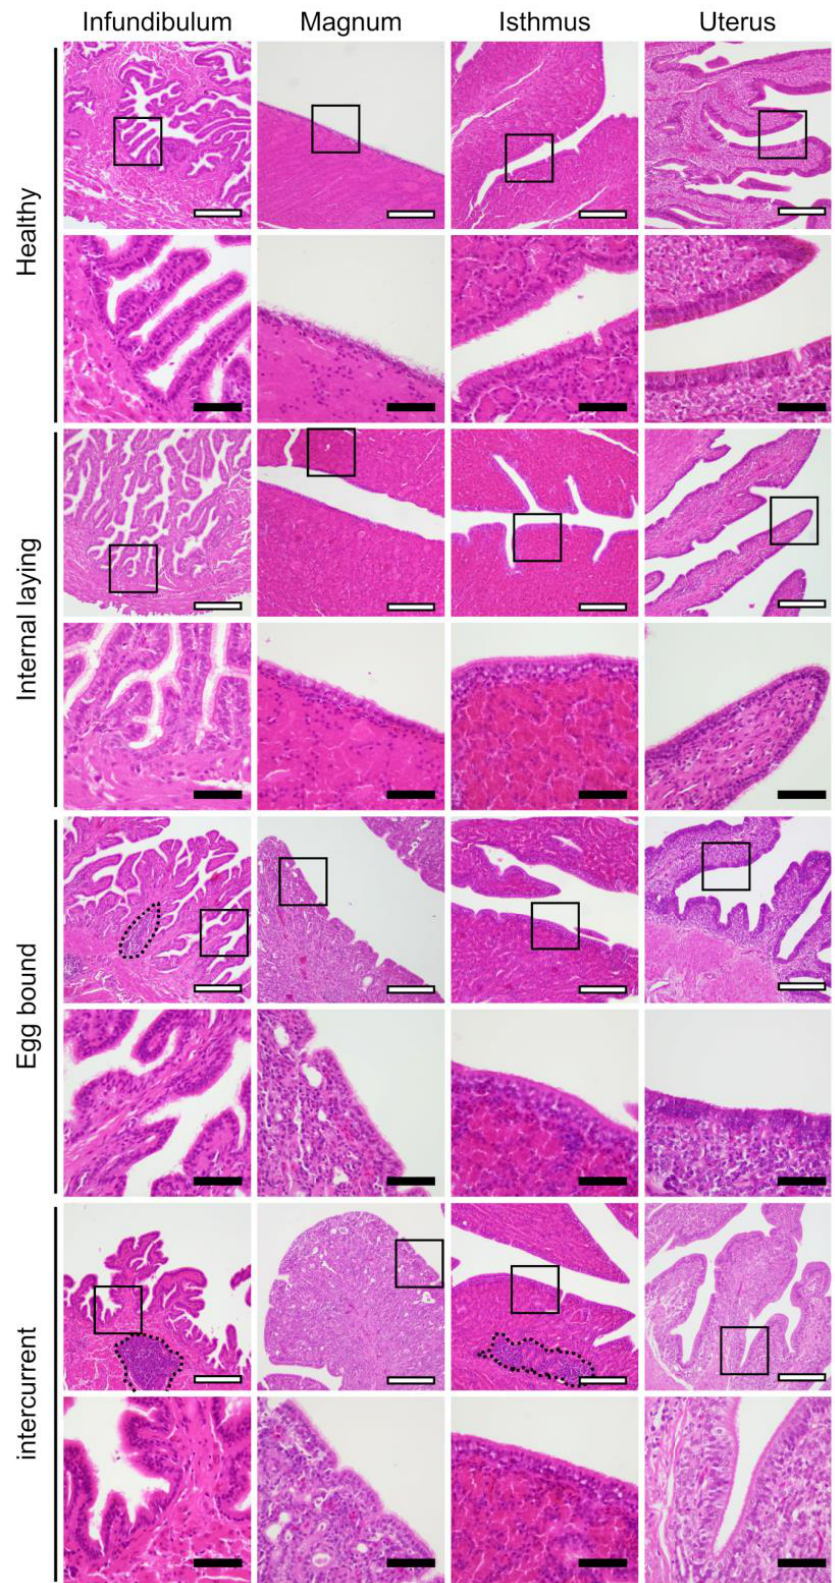
Figure 3. Histology of infundibulum, magnum, isthmus, and uterus of oviducts in laying hens. The squared regions are magnified into the below images. Dotted lines indicate the infiltration of mononuclear cells. White bar = 200 µm, black bar = 50 µm.